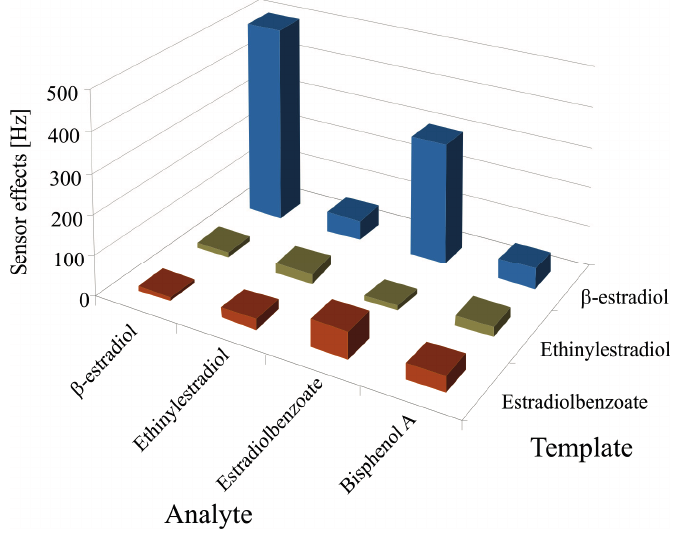
Figure 5. Selectivity pattern between β -estradiol (E2), and its structural analogues such as estradiolbenzoate (E2B) and ethinylestradiol (EE2). Sensor responses were also obtained by exposing to environmental estrogen, bisphenol A, which also affects the hormone